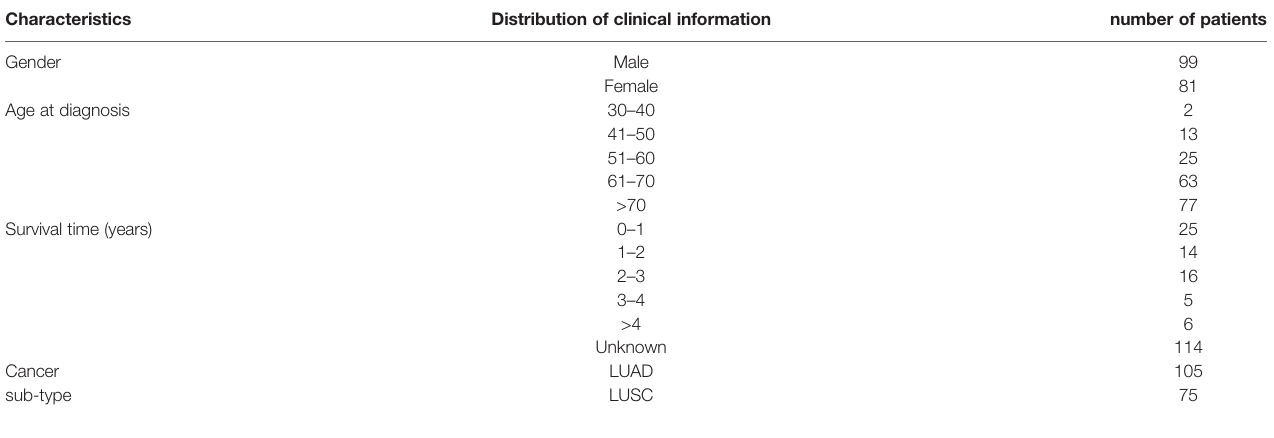
TABLE 1 | Clinical Characteristics of the Study